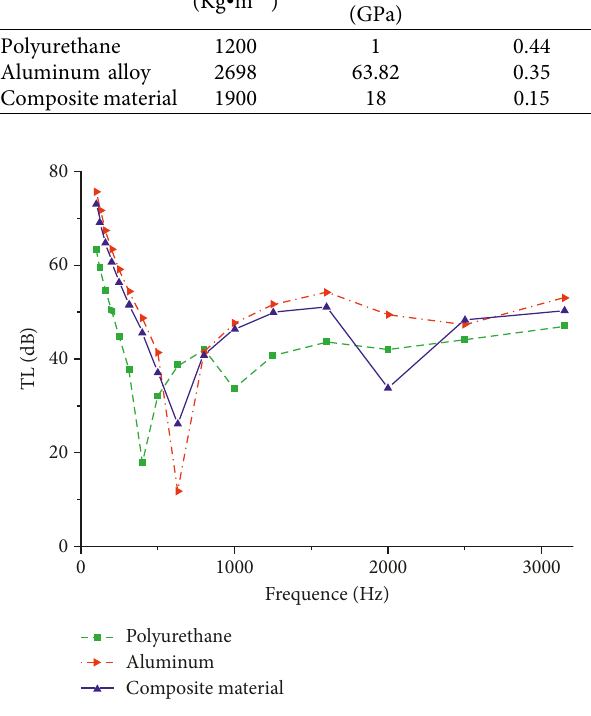
Figure 13: Influence of core material on sound insulation curve of